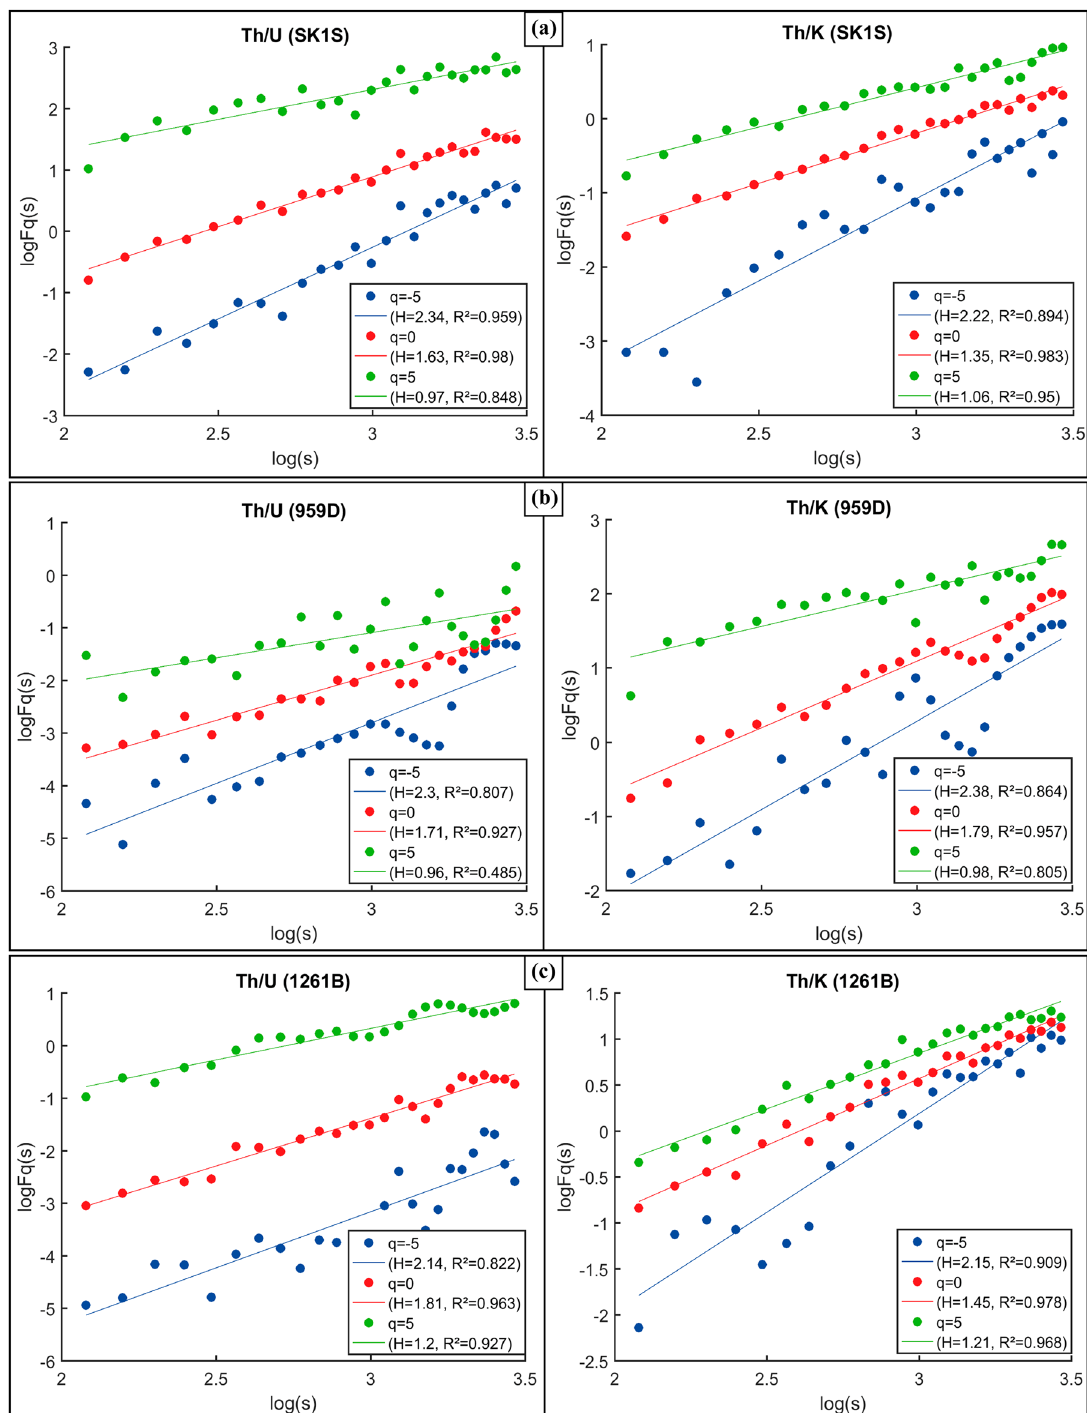
Figure 3. Scaling properties of log–log plots of the fluctuation function ( Fq ( s ) versus q ) of Th/U and Th/K ratios in the studied OAE3 units recorded in: ( a ) SLB (borehole south of the Chinese Continental Scientific Drilling Project: SK1S), ( b ) DIB (hole 959D of ODP Leg 159) and ( c ) DR (hole 1261B of leg 207); and their associated regression